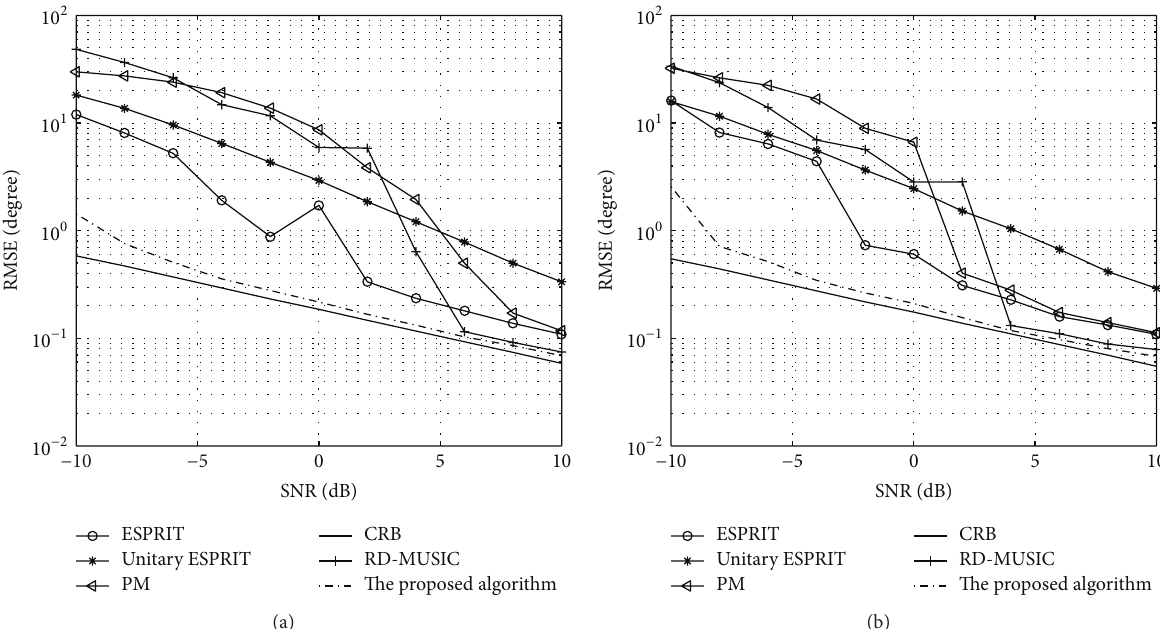
Figure 2: DOD and DOA estimation performance comparison. (a) DOD and (b) DOA.